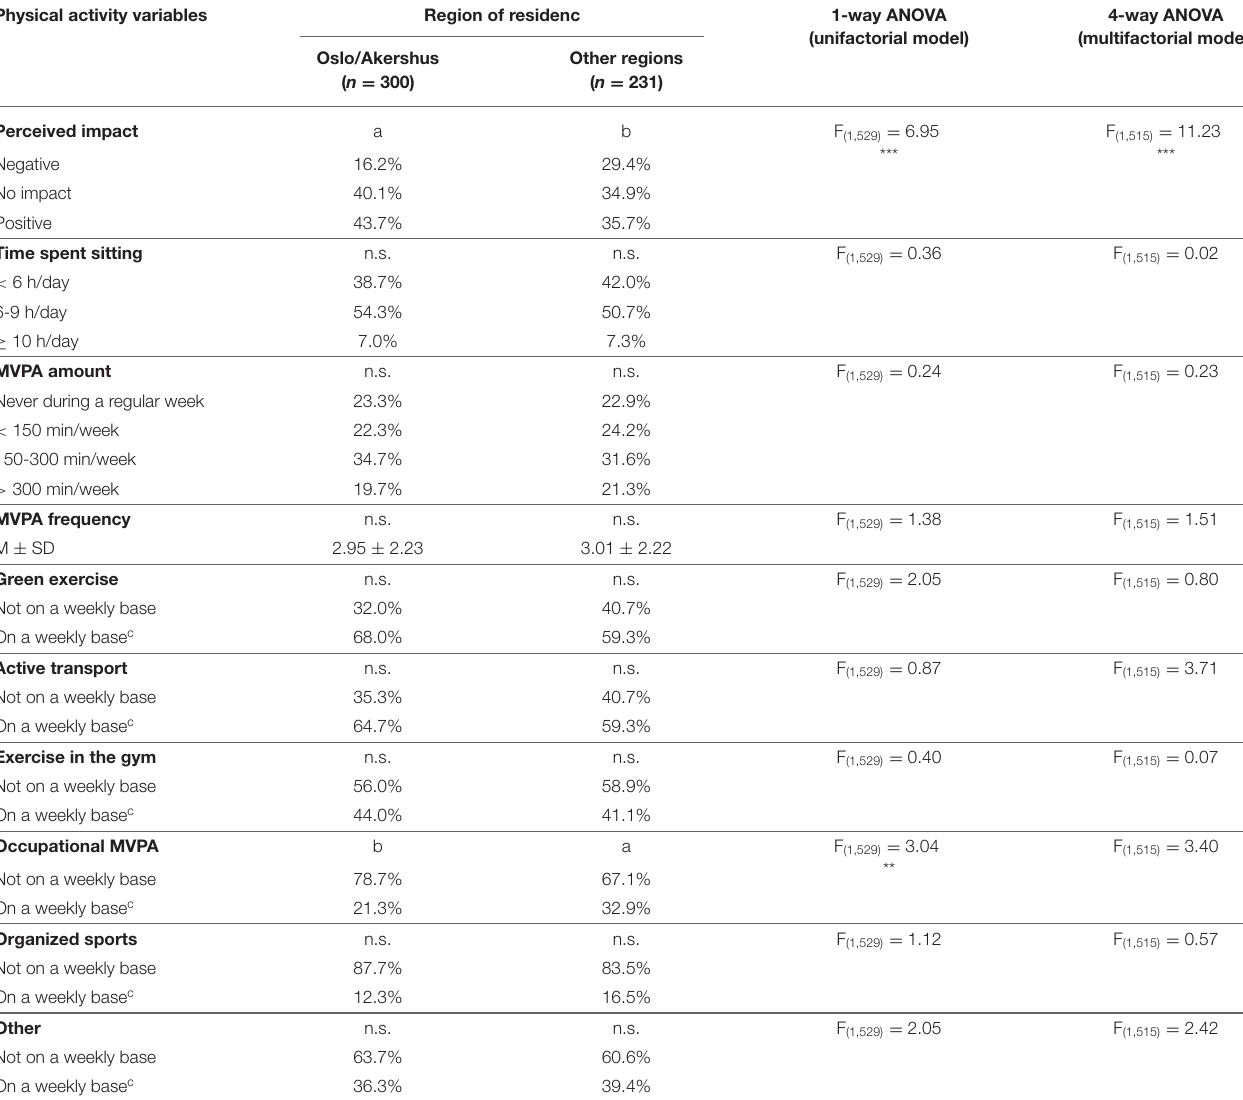
TABLE 5 | Physical activity profile of Italian immigrants in Norway, by region of residence ( n = 531). Physical activity